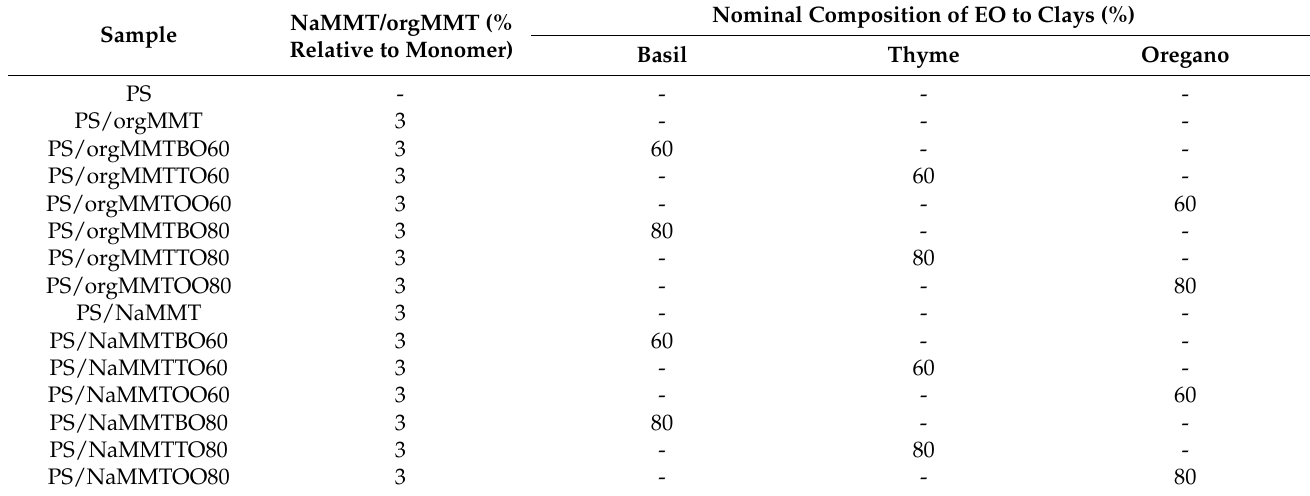
Table 1. Designation and amounts (wt %) of oregano oil, thyme oil, basil oil and sodium montmorillonite (NaMMT) or organo-modified montmorillonite (orgMMT) used for the preparation of all NaMMTEO hybrids and orgMMTEO hybrids.